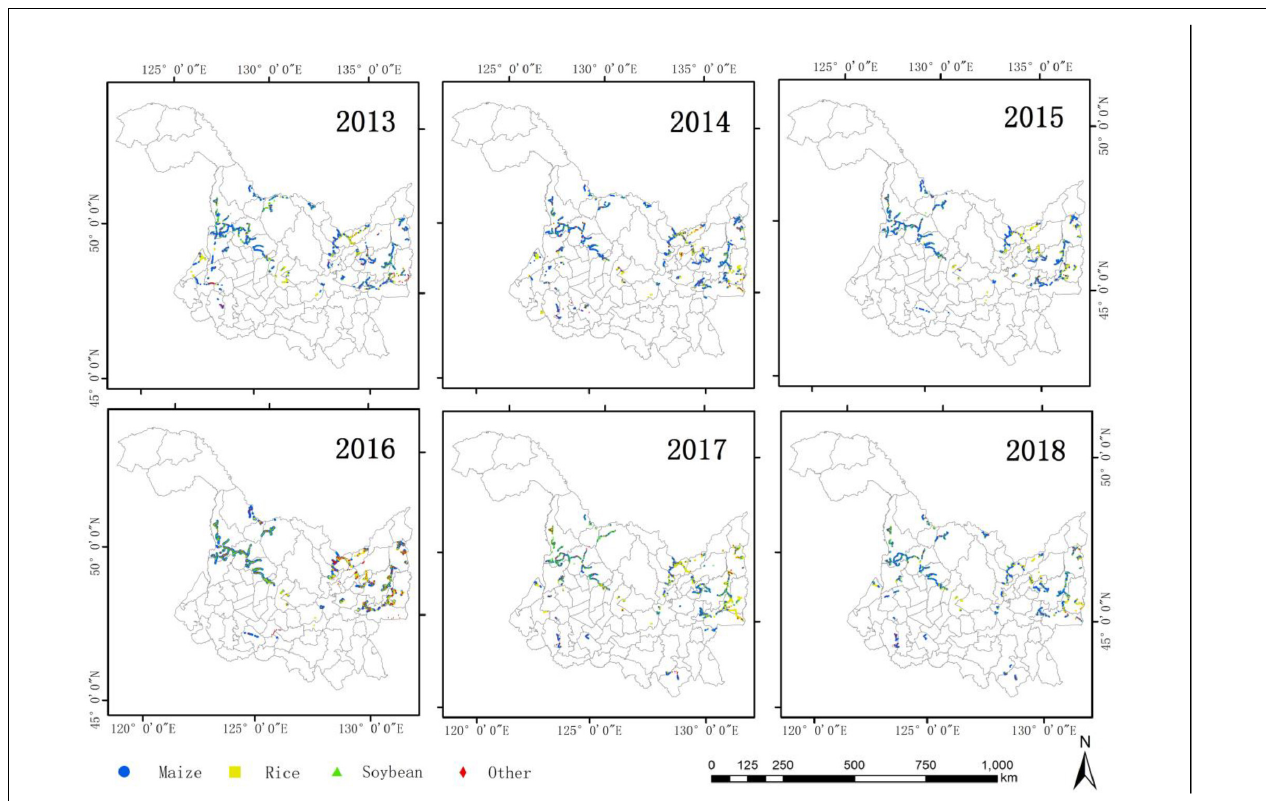
FIGURE 3 | Distribution of crop samples from 2013 to